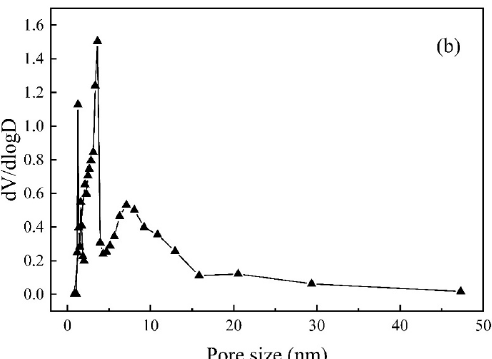
Figure 3. Pore structure parameters of Ce/MoO 3 /SiO 2 . ( a ) Adsorption desorption isotherm; ( b ) pore size distribution.